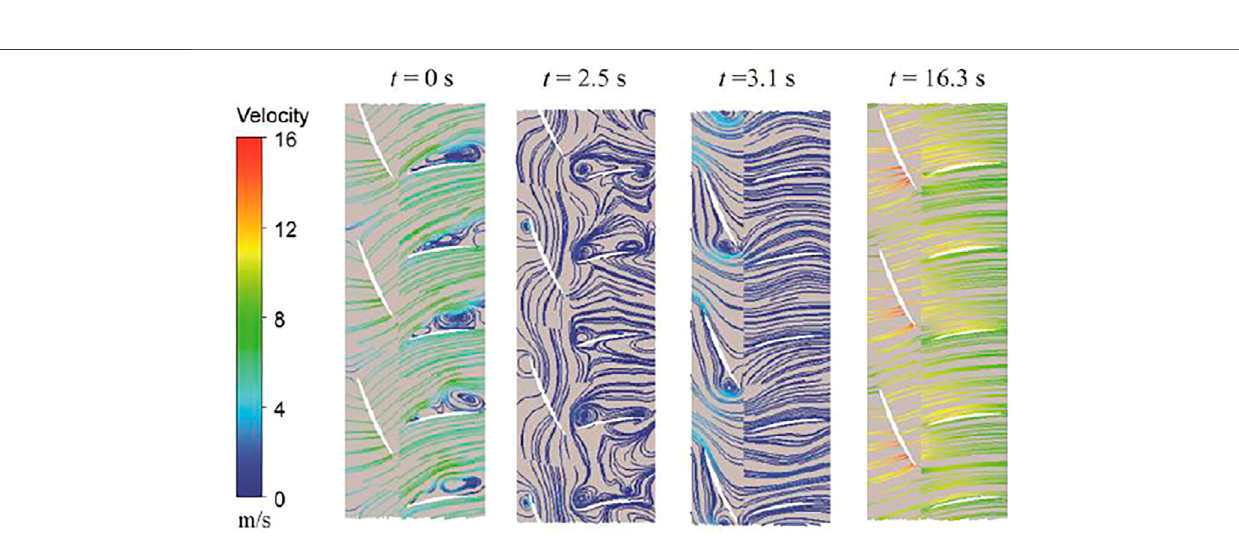
FIGURE 10 | Distribution of velocity streamlines at medium